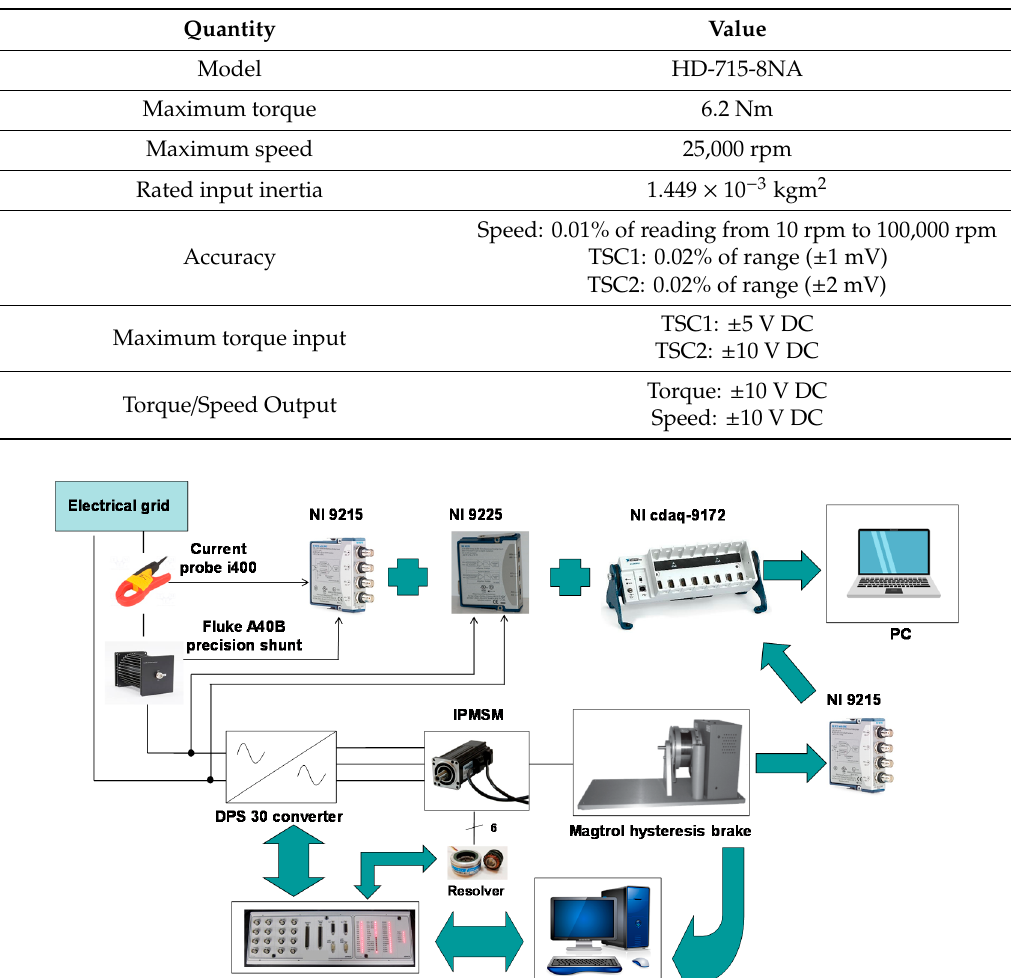
Table 1. Main features of the Magtrol hysteresis brake.